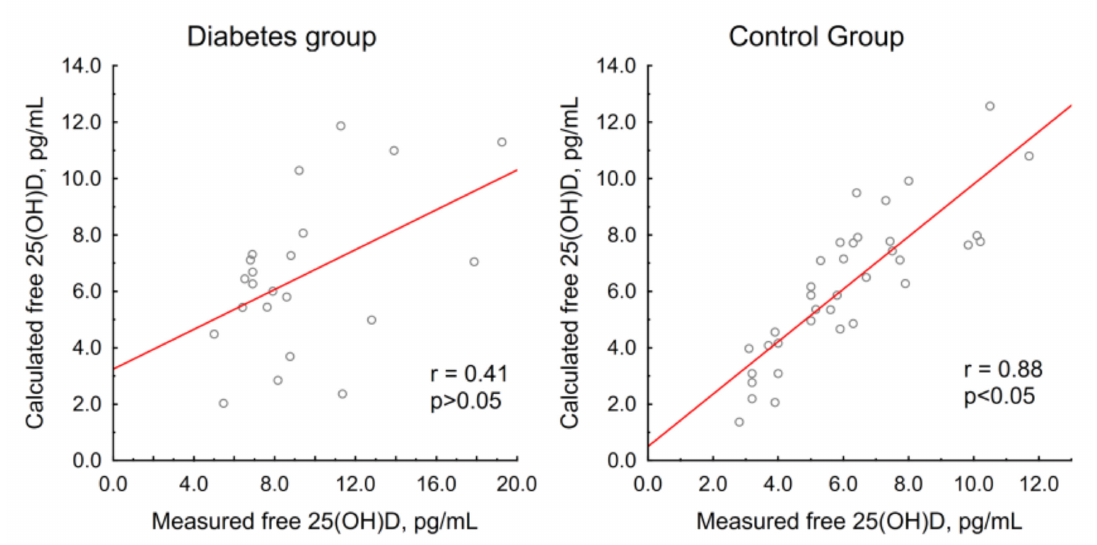
Figure 1. Relationship between measured and calculated free 25(OH)D in